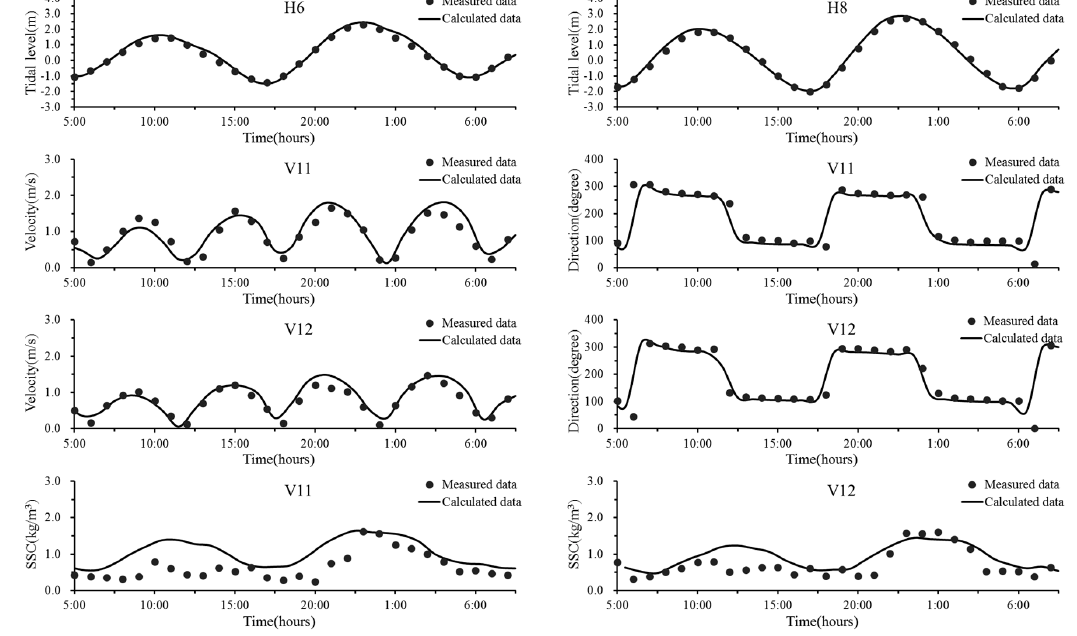
Figure 5. Comparison of calculated data and measured data at representative stations.